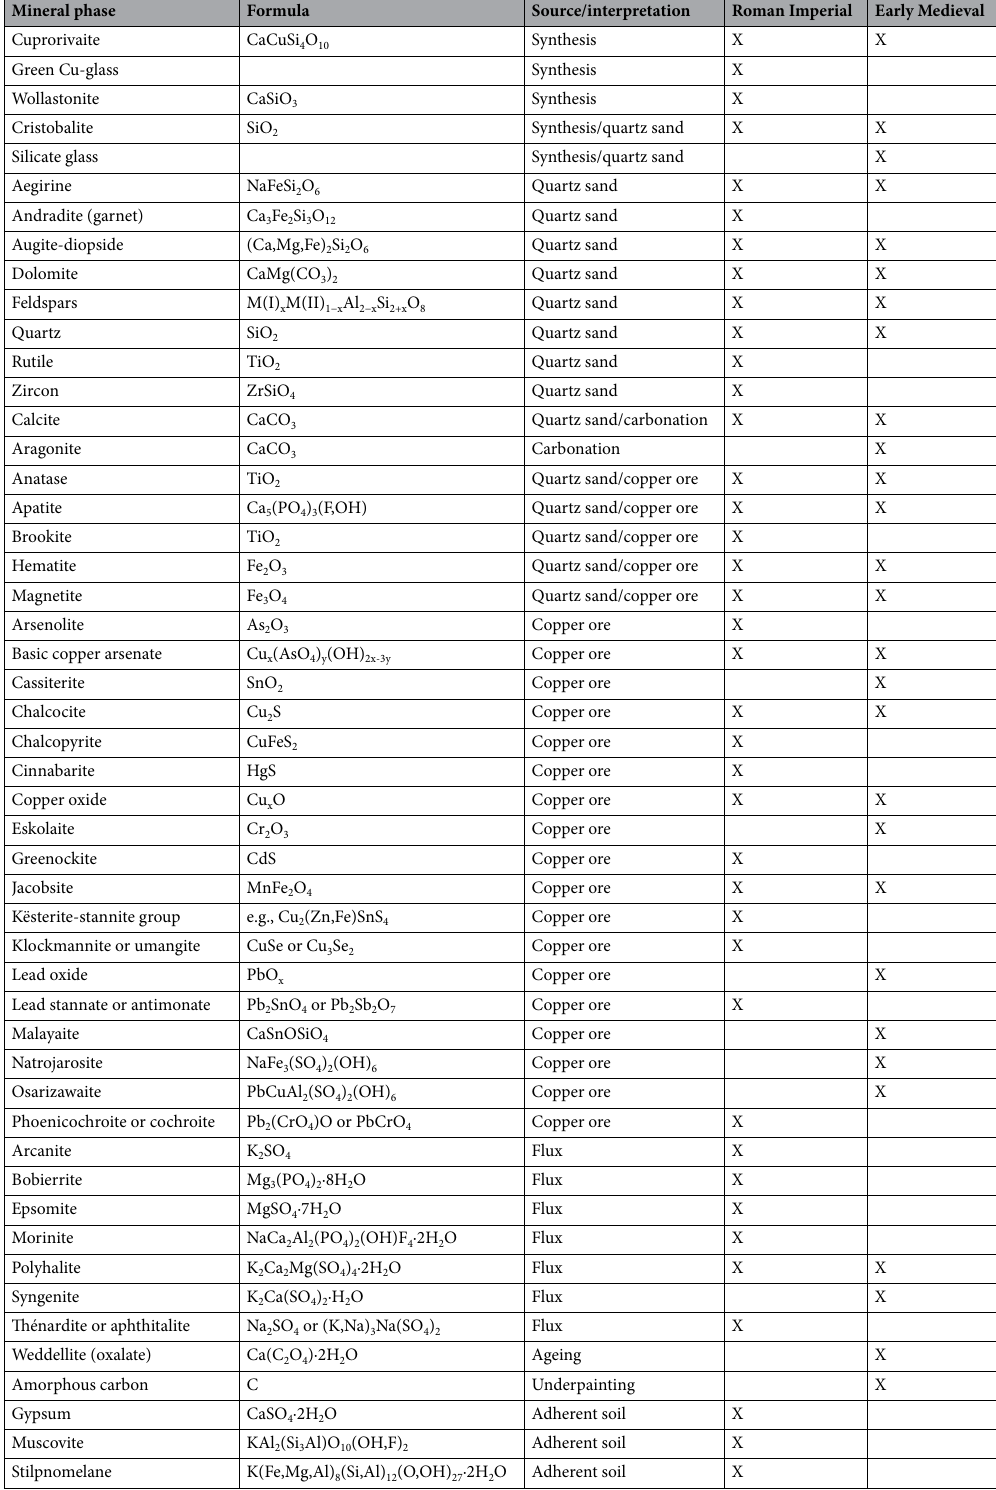
Table 1. Plethora of minerals identified in the Roman Imperial pigment balls and fragmentary wall paintings under study as well as in the monochrome blue paint layer of an Early Medieval mural fragment originating from St. Peter ob Gratsch (South Tyrol, Italy) 17 by Raman